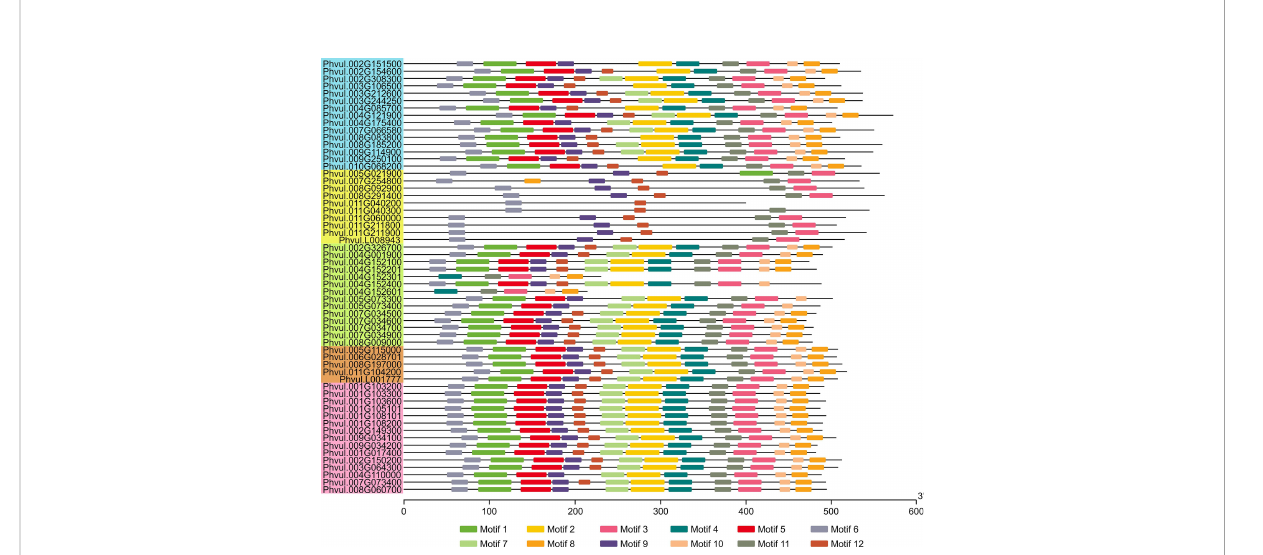
FIGURE 5 Conserved protein motifs of the MATE family in common bean. Colored boxes on lines are the conserved motifs and for protein length estimation, scale is provided on the bottom in amino acids units. The logo presentation of the conserved sequence is given in Supplementary Figure S4. PvMATEs are listed according to the order of clades and sub-clades from C1 to C4 as the phylogenetic tree in Figure 4 and accordingly